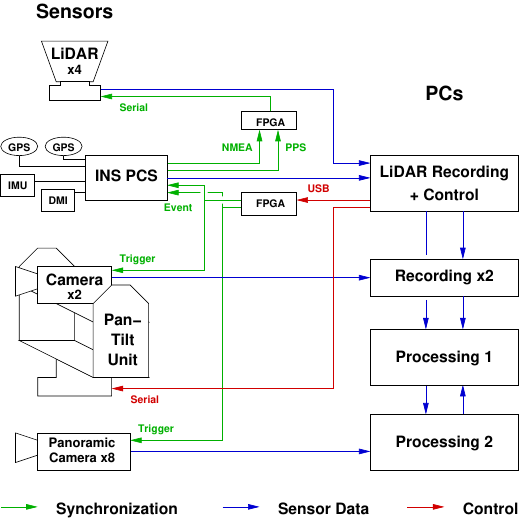
Figure 2. Simplified schematic of data paths for synchronization, data acquisition and control. Sensors operated the same way are only represented